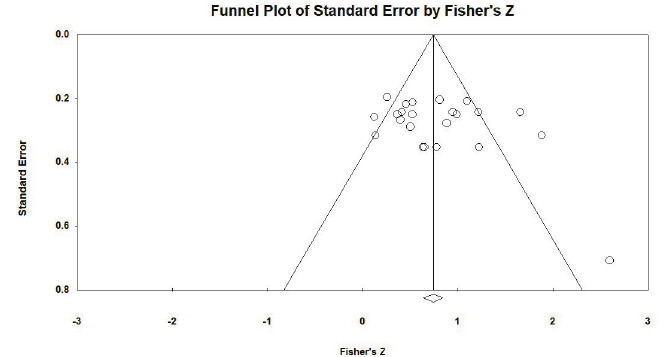
Fig. 1 Distribution funnel value of the relationship between tourism revenue and economic growth